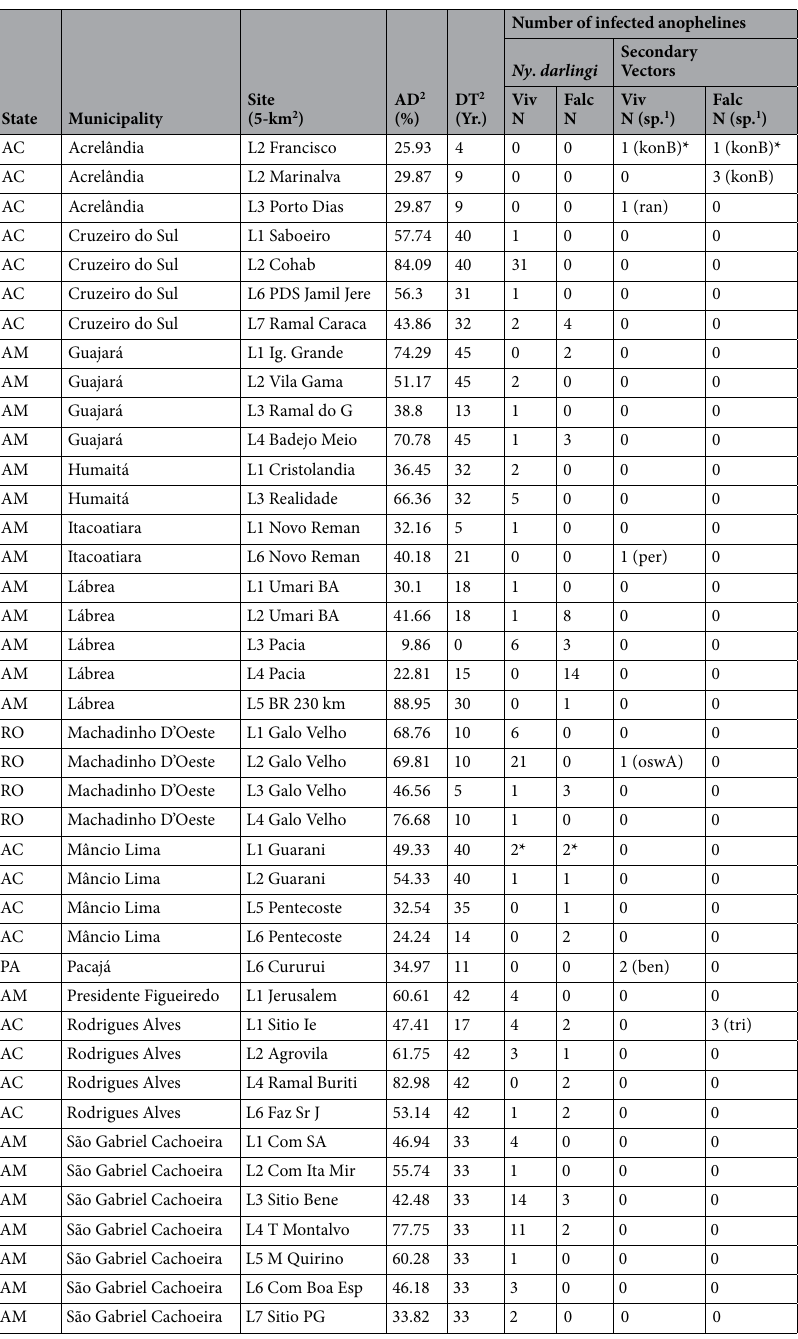
Table 2. Number of infected anophelines, accumulated deforestation and deforestation timeline by site, municipality, and state, 2015–2017. 1 ben, Ny . benarrochi s.l.; konB, Ny . konderi B; oswA, Ny . oswaldoi A; per, An . peryassui ; ran, Ny . rangeli ; tri, Ny . triannulatus. 2 site features: AD, accumulated deforestation (%); DT, deforestation timeline (age of settlement in years). * one mixed infection ( P . vivax and P . falciparum